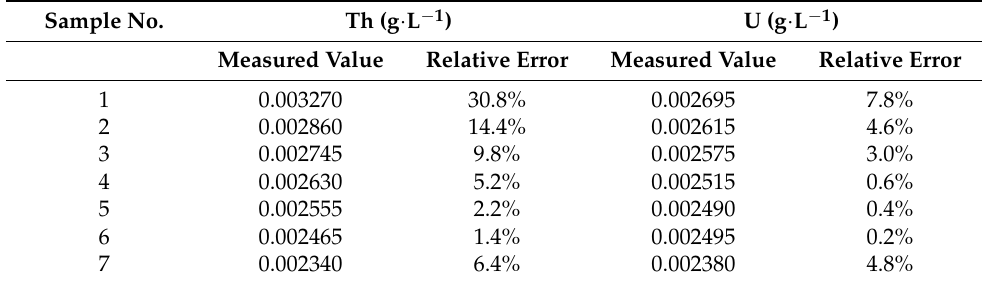
Table 7. Influence of scandium matrix on determination of Th and